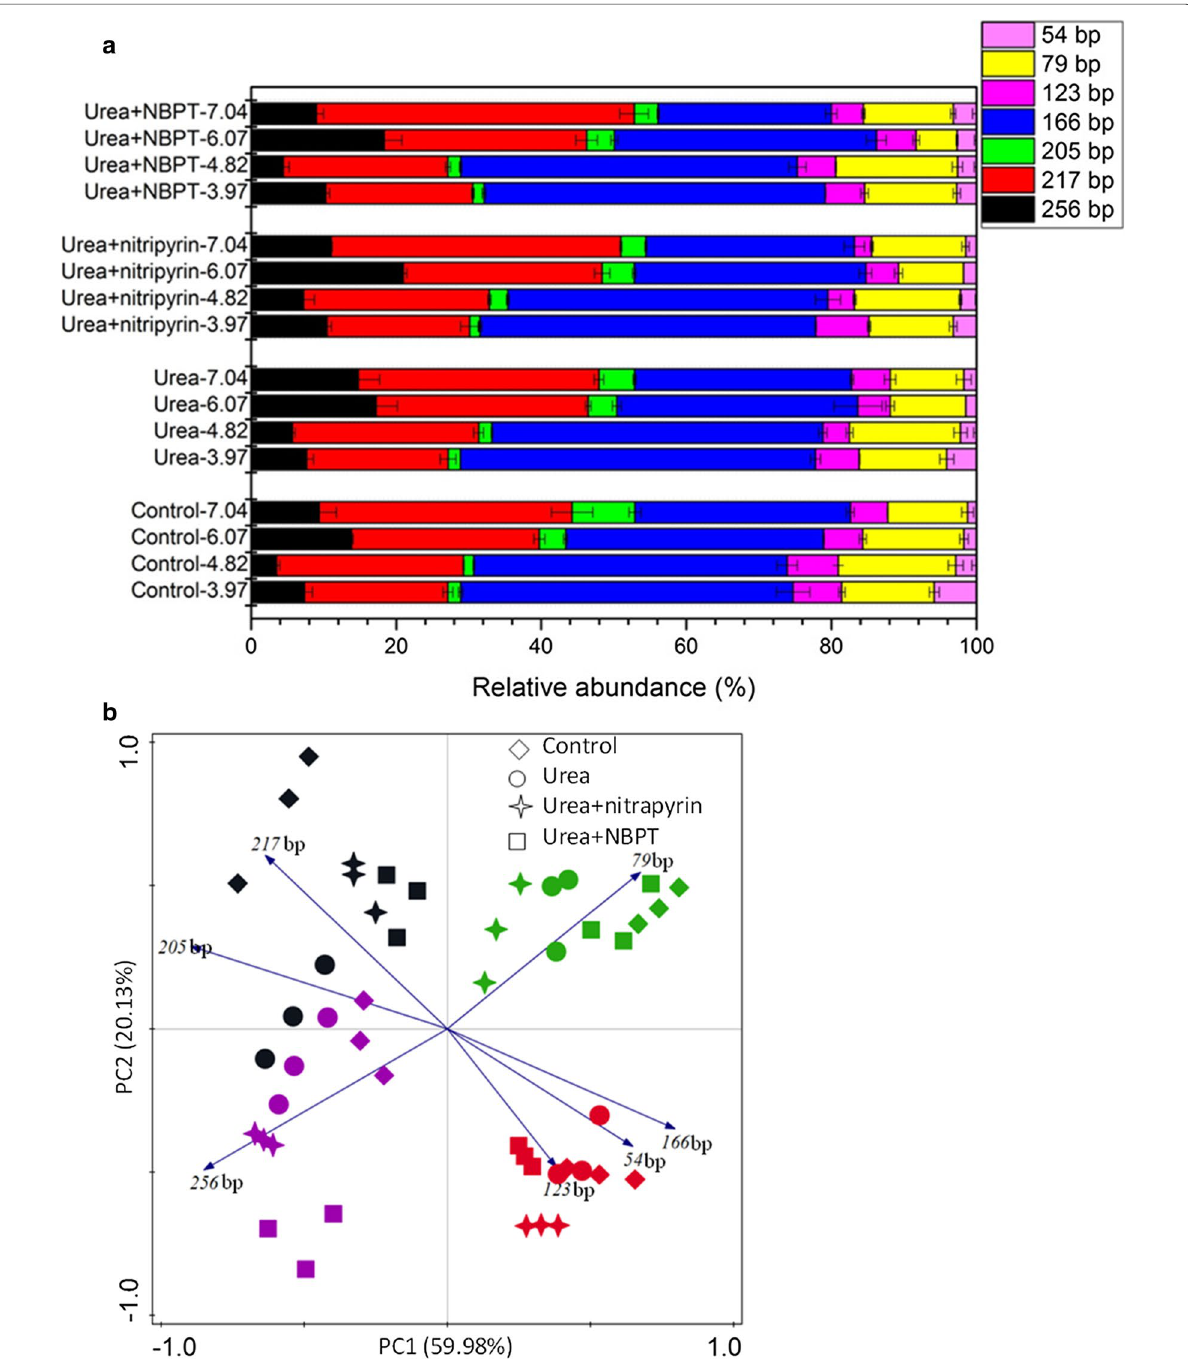
Fig. 4 Abundance ( a ) and principle component analysis ( b ) of AOA T‑RFs in vegetable soils treated with control, urea, urea NBPT at different pH. Error bars indicate standard errors of three replicates. Different pH represented by different colors, red , green , purple and black + color indicate treatments at pH 3.97, pH 4.82, pH 6.07 and pH 7.04,